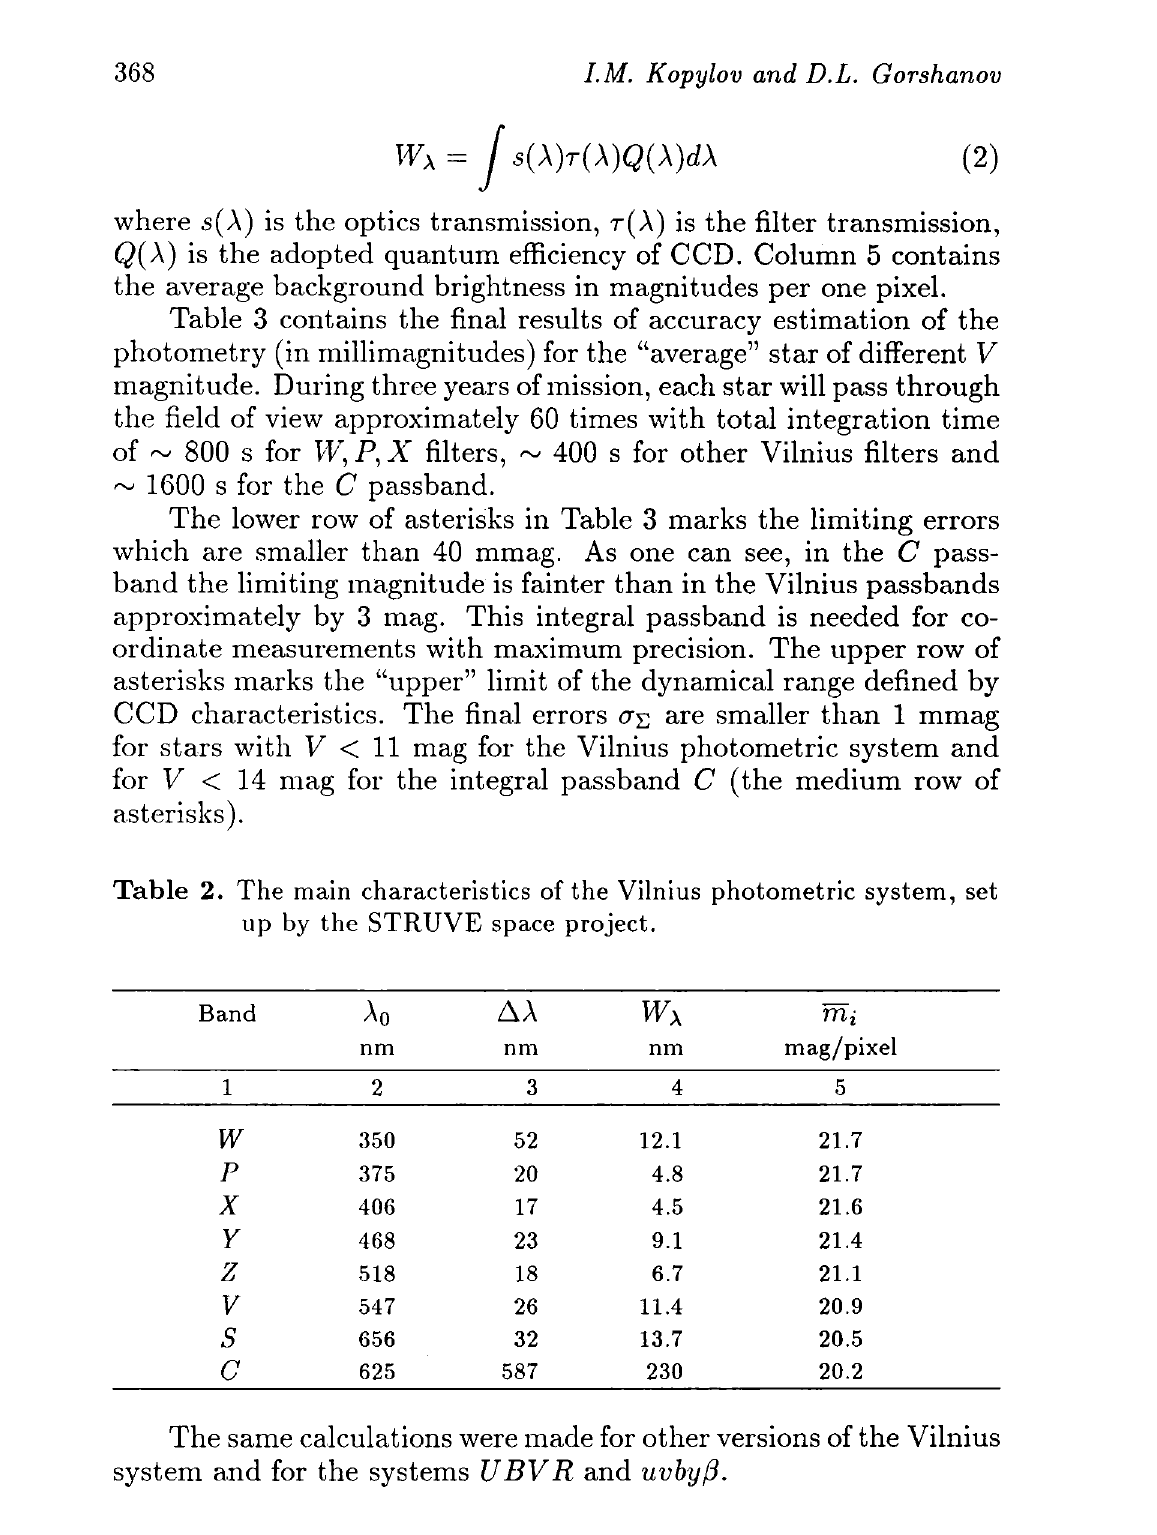
Table 2. The main characteristics of the Vilnius photometric system, set up by the STRUVE space